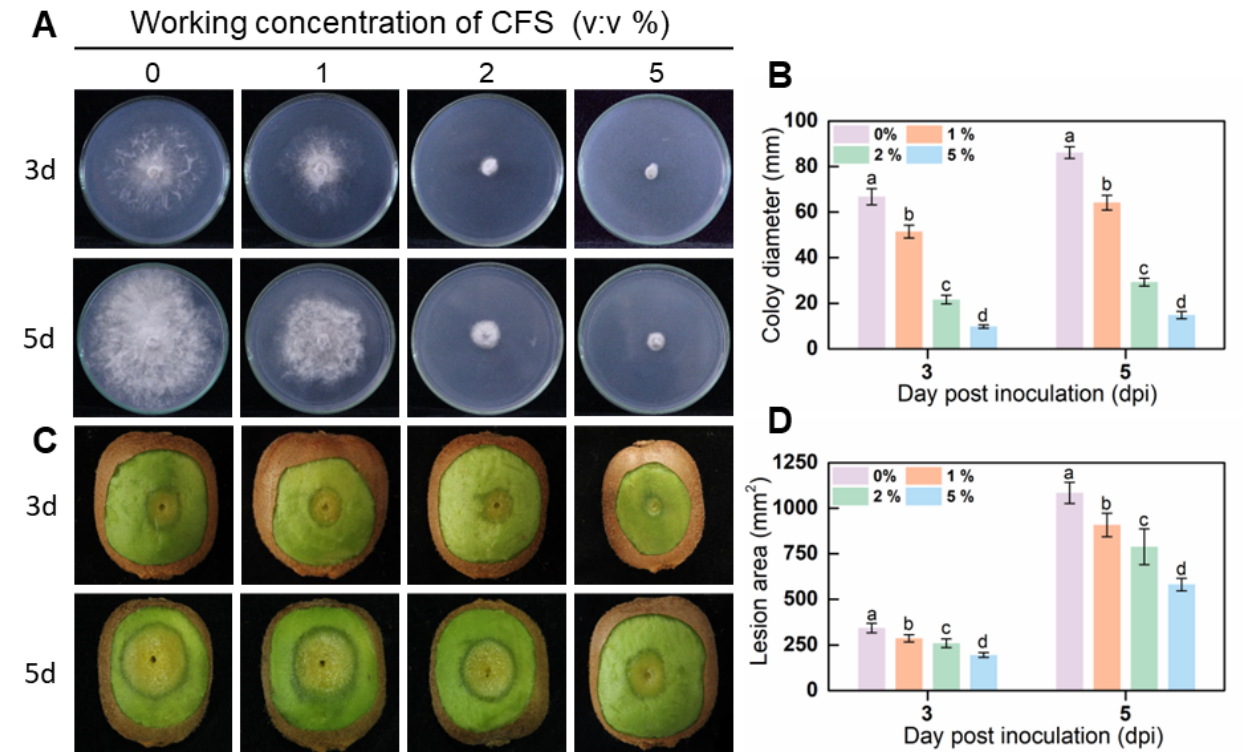
Figure 1. The CFS inhibited vegetative growth of B. dothidea on the PDA (potato dextrose agar) plate ( A , B ) and reduced the pathogenicity of B. dothidea in kiwifruit ( C , D ). ( A ) Images were recorded after 3 and 5 days of incubation. ( B ) Statistical analysis for colony diameters. ( C ) Photographs of diseased fruits were taken 3 and 5 days after treatment. ( D ) Lesion area on harvested kiwifruit was measured using Image J. Histograms with different letters indicate significant differences according to Duncan’s multiple range tests at p < 0.05.